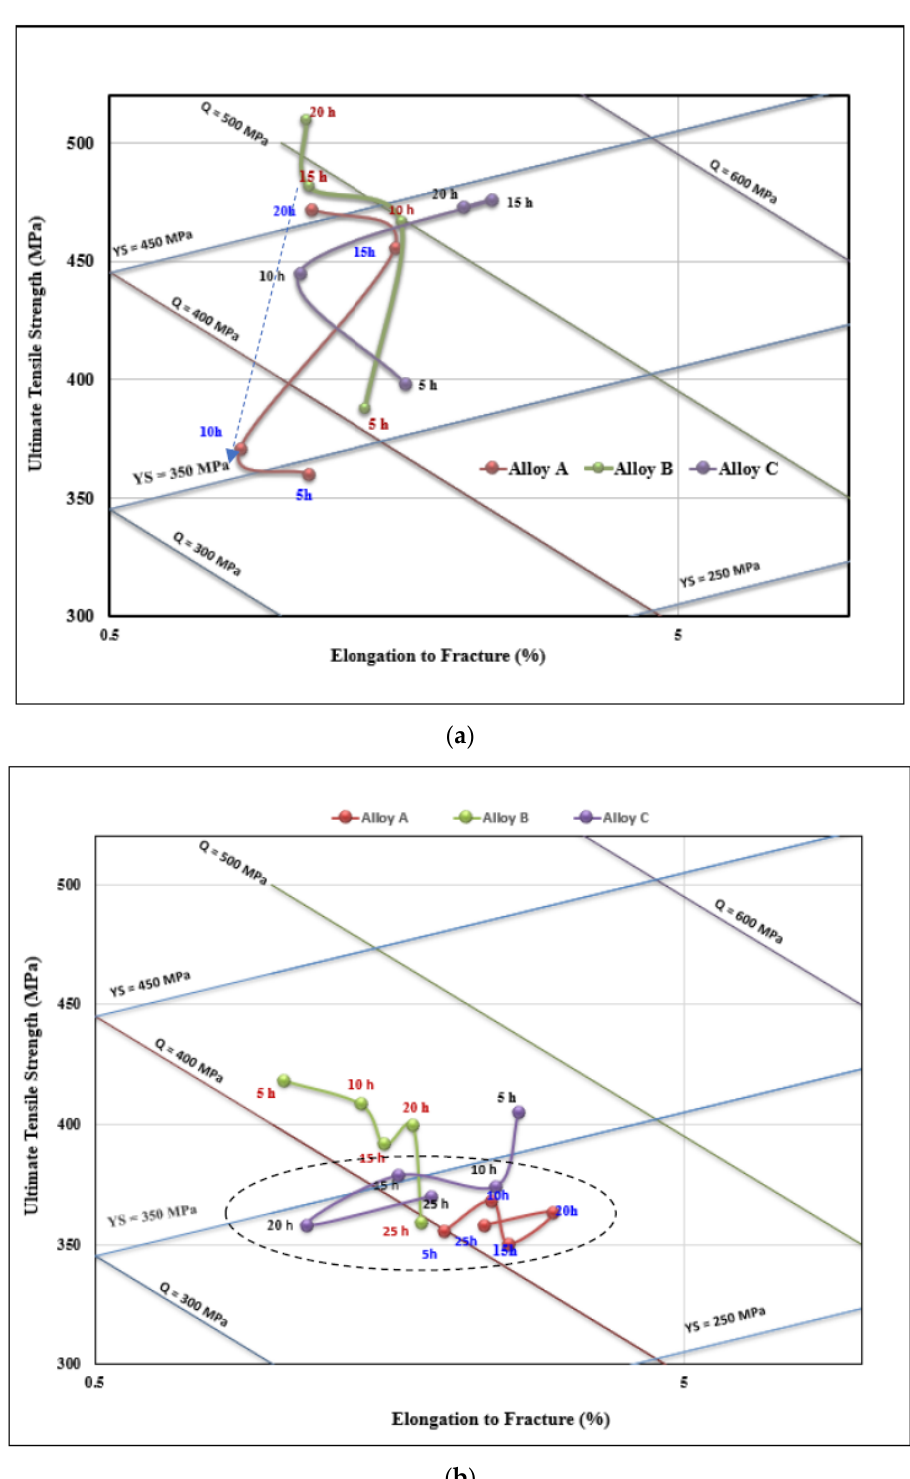
Figure 15. Q-charts calculated using Equations (3) and (4) for ( a ) 155 °C, and ( b ) 220 °C aging temperatures.